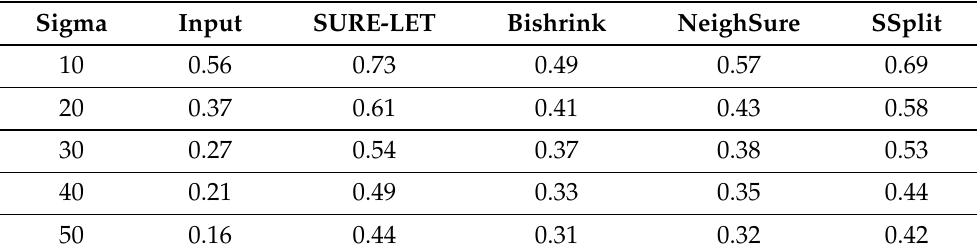
Figure 20. ( a ) Binary image, ( b ) Dilated image with the addition of Gaussian white noise (Input PSNR = 18.59 dB), ( c ) SURE-LET method (Output PSNR = 32.21 dB), ( d ) SSplit method (Output PSNR = 33.23 dB). Table 4. Comparison of the proposed methods with the other wavelet-based image denoising methods on the ‘Pepper’ image in terms of the structural similarity (SSIM) for a range of input noise levels σ = 10 to σ = 50